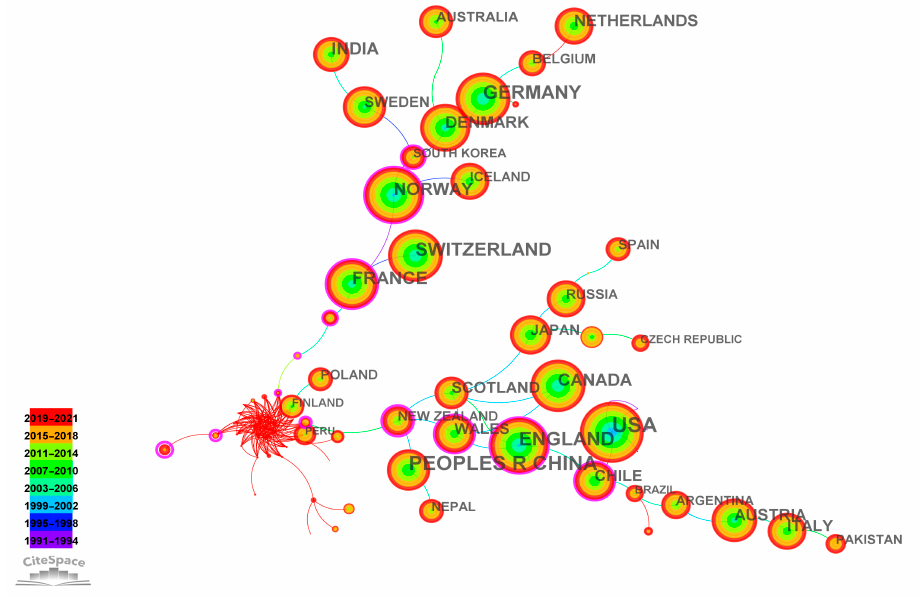
Figure 6. Knowledge map of country collaboration.